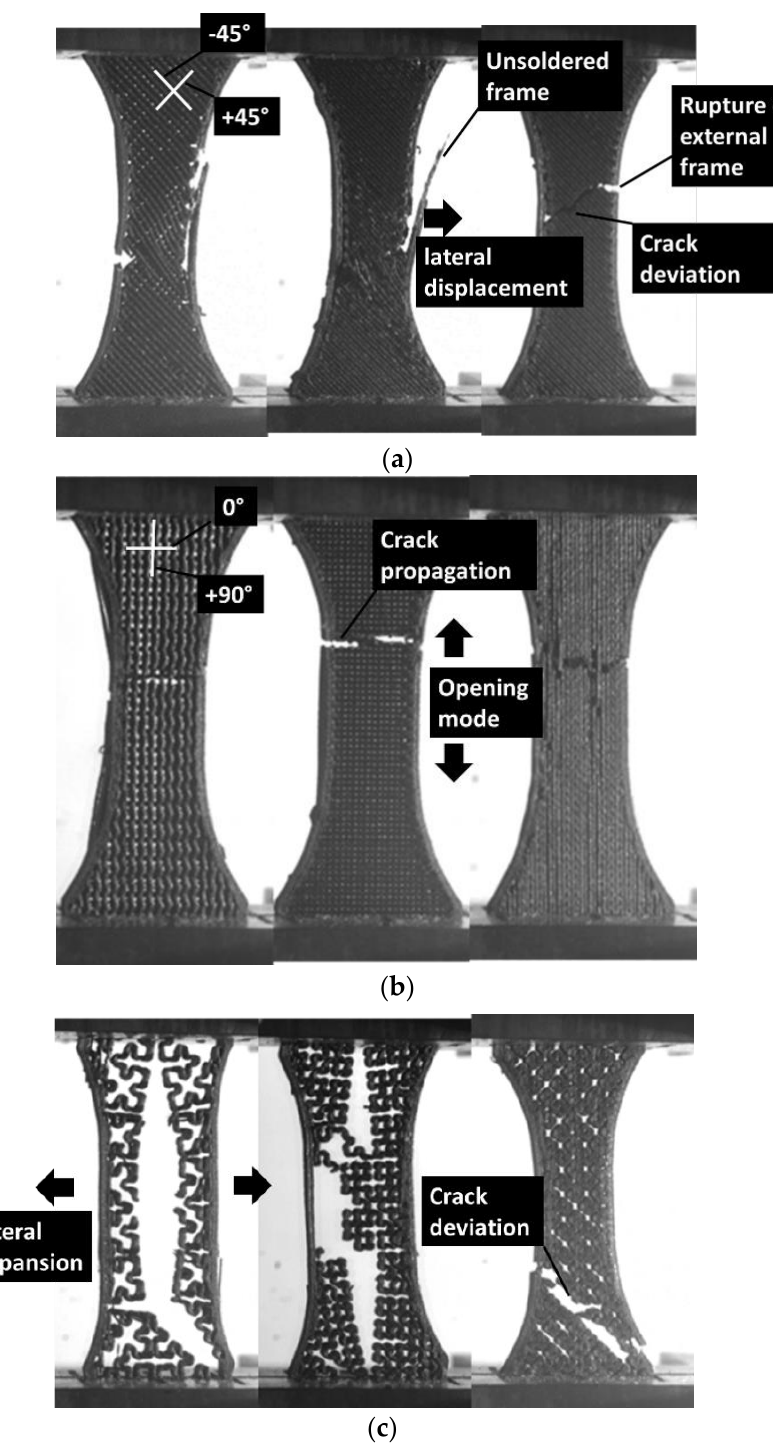
Figure 3. Patterns at the rupture point as a function of density (left to right from 50% to 100%): ( a ) zigzag, ( b ) gyroid, ( c ) cross.